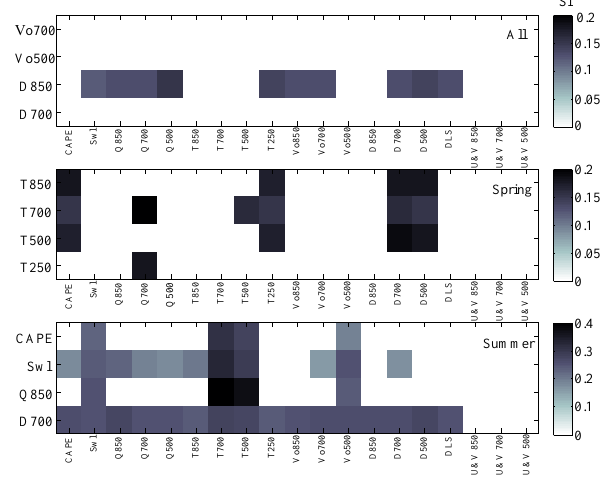
Figure 5. Top panel: the SI value for each pair of atmospheric in- dicators for all synoptic events using the daily value and the mean value over 10days. Middle panel: the SI value for each pair of at- mospheric indicators for the Ss events (3-day and 8-day averages). Bottom panel: the SI value for each pair of atmospheric indicators for Sr using (daily value and 8-day average). Any value that was not significant at p =0.10 level was given a value of